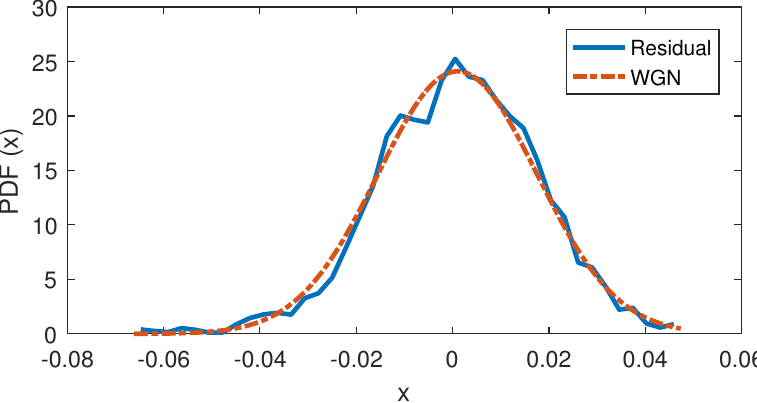
Figure 12. Comparison of PDF of residual and